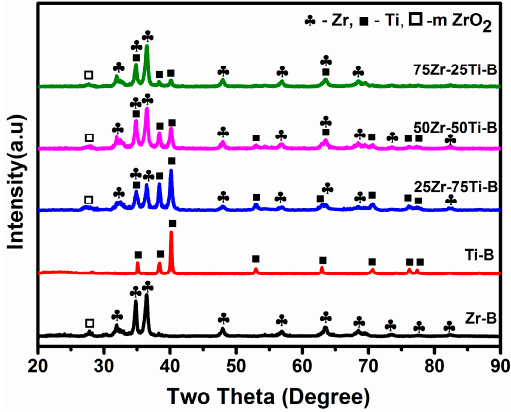
Figure 1. X-ray diffractogram of 0.5 h ball milled elemental powders.